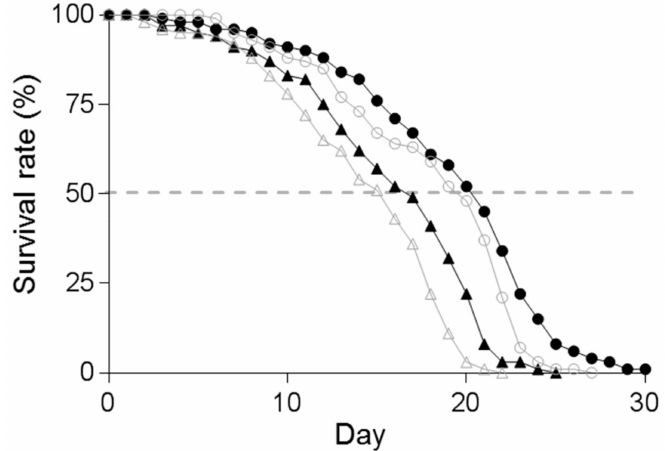
Figure 7. E ff ect of spermidine on lifespan in control and B 12 -deficient worms. Control